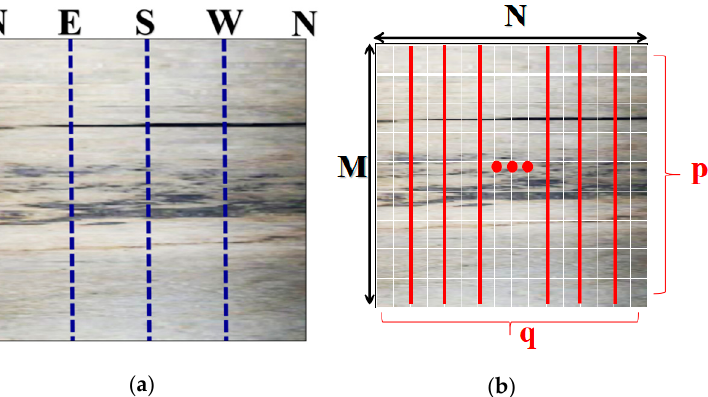
Figure 4. Optical image and grid division. ( a ) Optical unfolded image, ( b ) grid division of optical unfolded image.